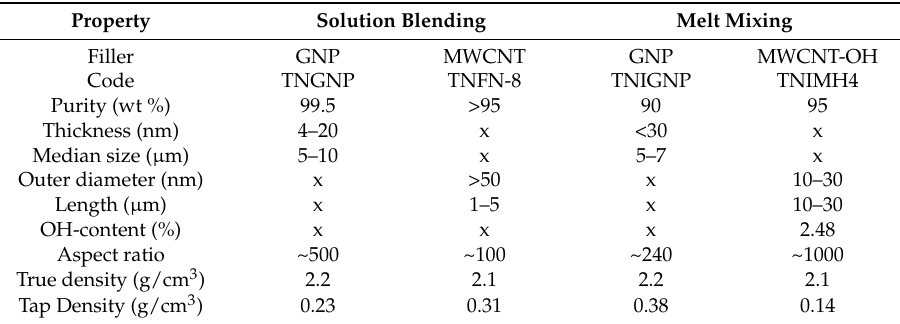
Table 1. Characteristics of carbonaceous fillers used in